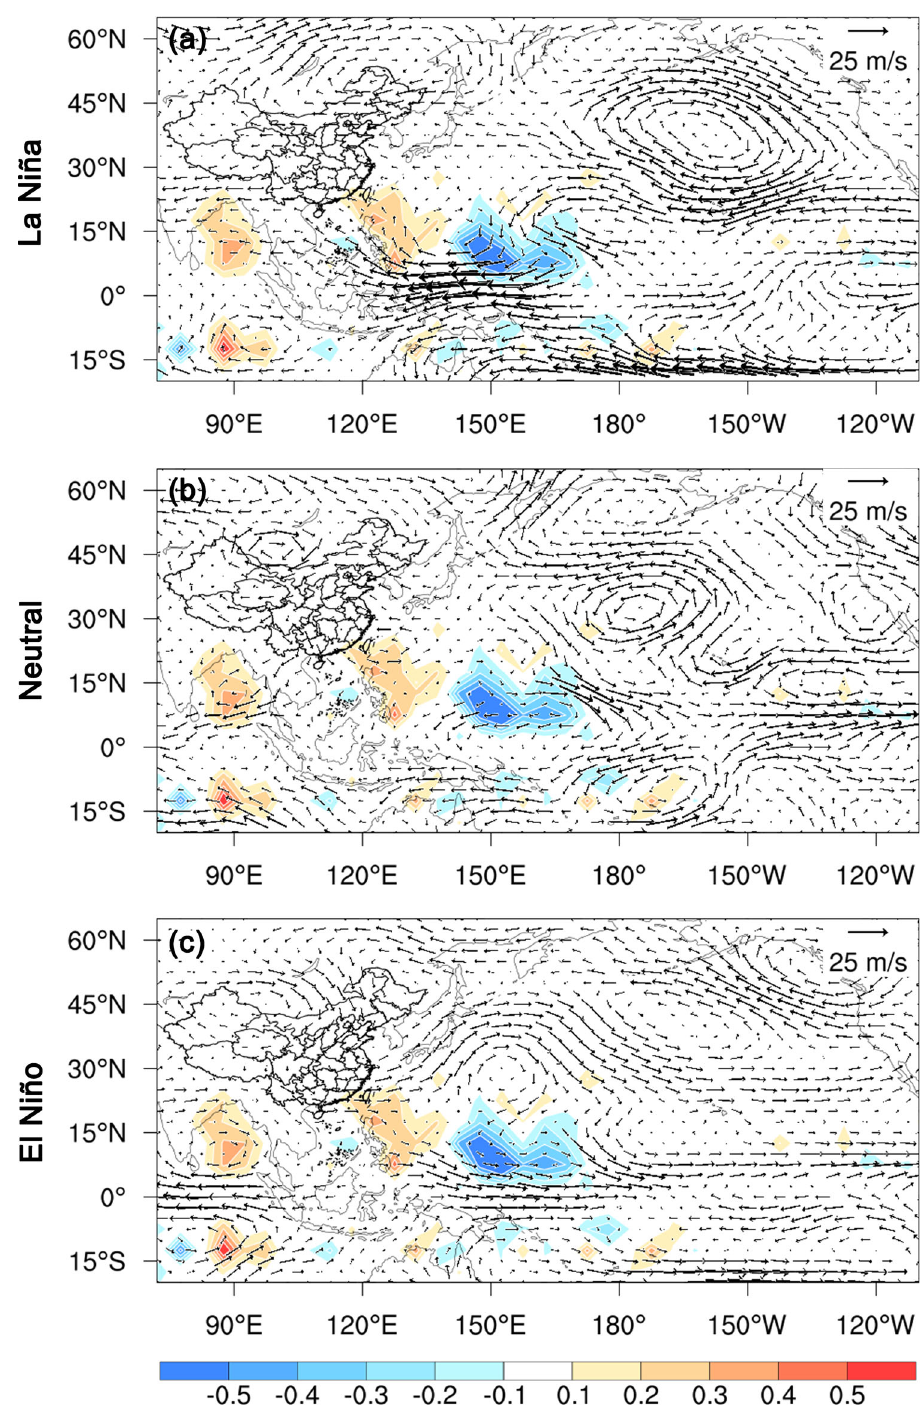
Fig. 10 Composited steering flow (m/s) anomalies (arrows) and tropical cyclone (TC) genesis anomalies (shadow) during La Nin˜a phase ( a ), neutral phase ( b ), and El Nin˜o phase ( c ). TC genesis density is calculated by binning the longitude and latitude of